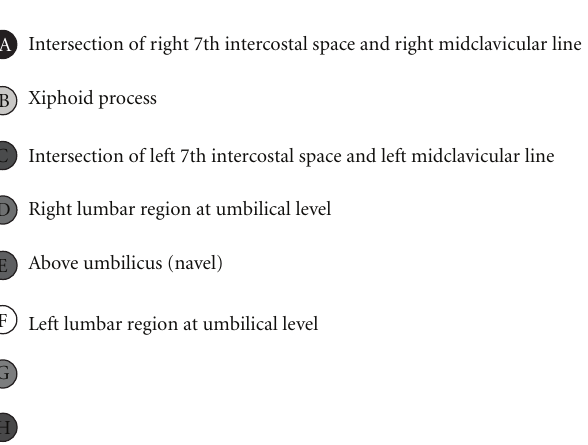
Figure 3: Common setup of antenna leads on the patient’s body [27].